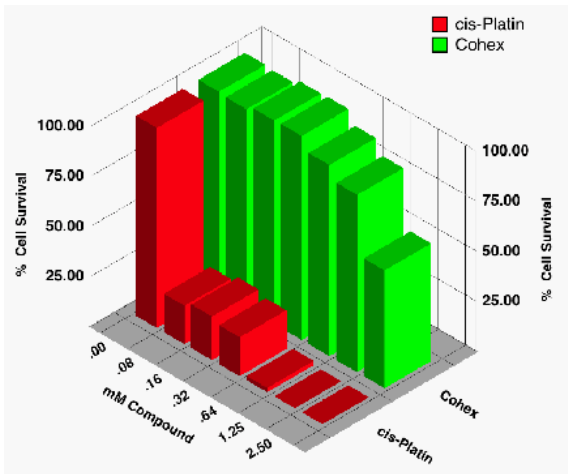
Figure 16. Comparison of cytotoxicity of Cohex against BHK cells with commercial drug cisplatin using